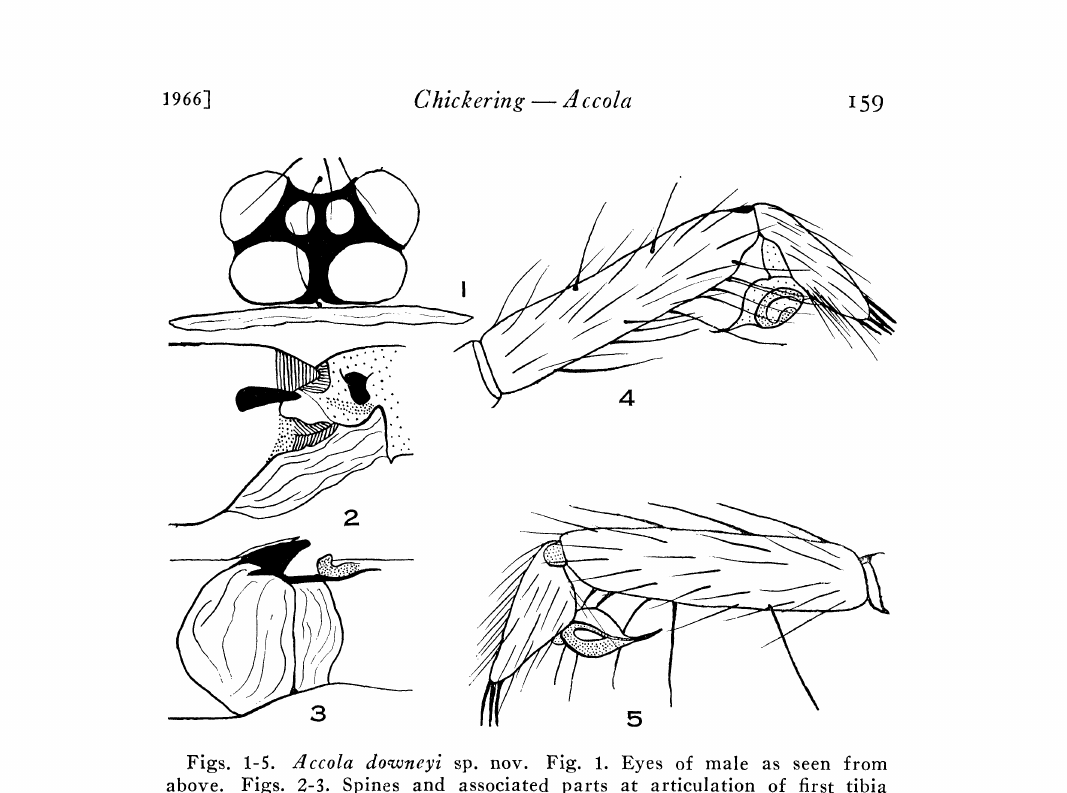
Figs. 1-5. Accola doneyi sp. nov. Fig. 1. Eyes of male as seen from above. Figs. 2-3. Spines and associated parts at articulation of first tibia and metatarsus of male holotype; prolateral and ventral views, respectively. Figs. 4-5. Left palpal tibia and tarsus of male holotype; prolateral and retrolateral views,